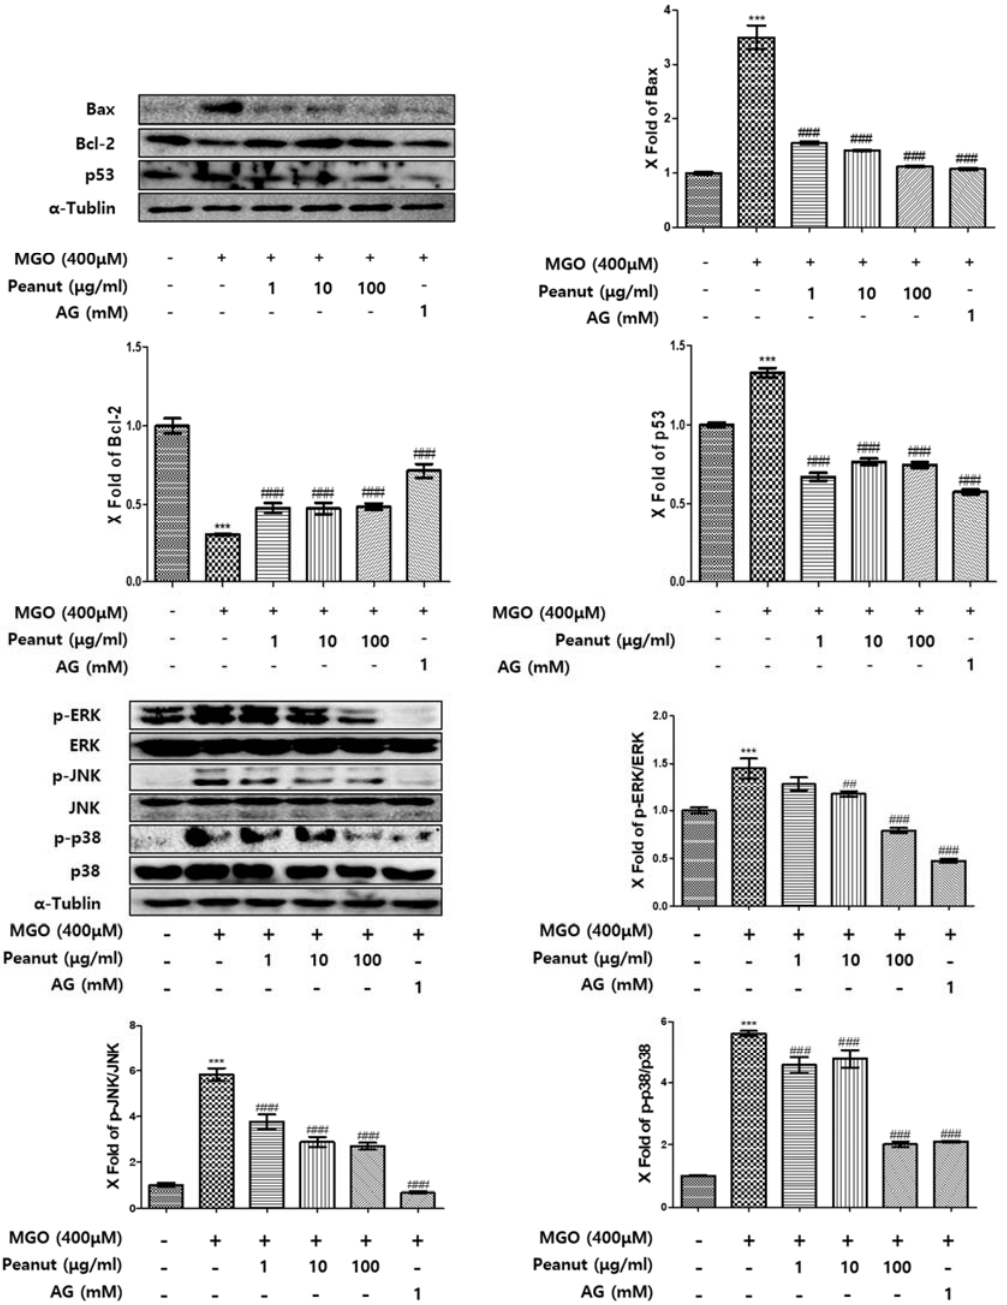
Figure 3. The effects of peanut extract on the expression of apoptosis ‐ related proteins and the activation of mitogen ‐ activated protein kinases (MAPKs). Cells were pretreated without ( − ) or with (+) peanut extract or aminoguanidin for 1 h, followed by treatment with 400 μ M methylglyoxal for 1 h (for MAPKs) or 24 h (for Bax, Bcl ‐ 2, and p53). Bar values are presented as the mean ± SD of three independent experiments. (*** p < 0.001 vs. control; # p < 0.05, ## p < 0.01, and ### p < 0.001 vs. methylglyoxal treatment only).